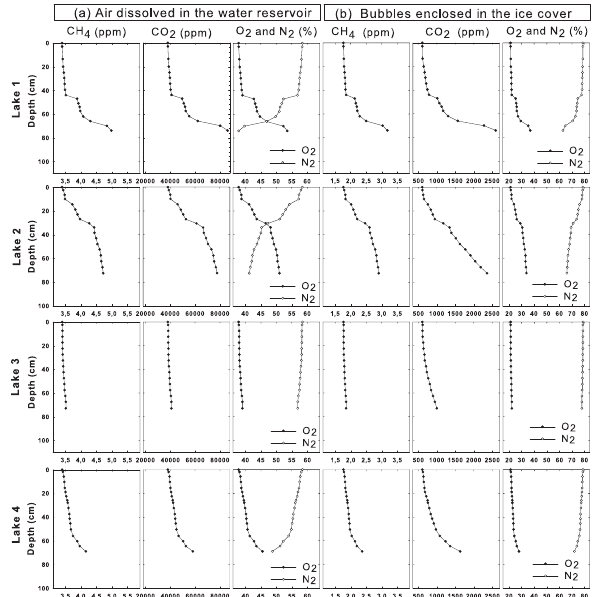
Fig. 8. Theoretical evolution of mixing ratios for (a) air dissolved in water and (b) bubbles in ice, assuming lakes are closed reservoir, using observed total gas contents and equilibrium mixing in water from Henry’s law for mass balance in the ice and assuming no gas fractionation occurs at the ice water interface (see text for